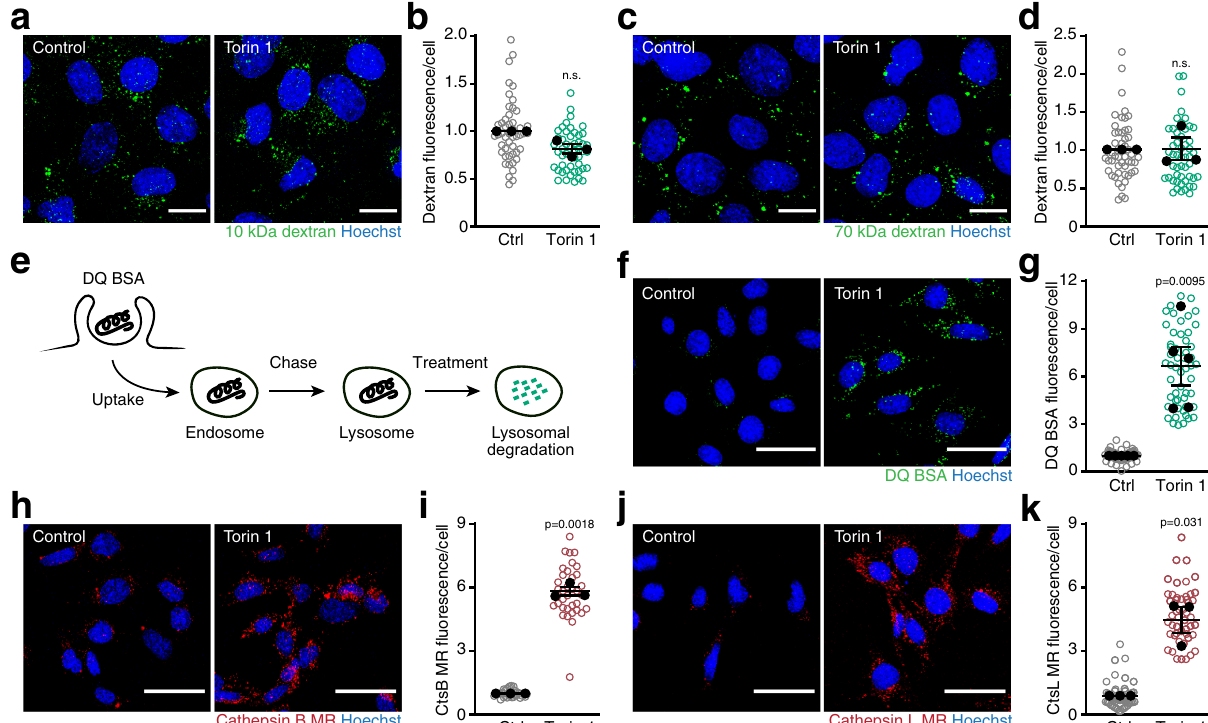
Fig. 1 | Degradation of extracellular proteins is suppressed by mTORC1 at the step of lysosomal catabolism. a – d Intracellular levels of fl uorescently labelled a , b 10kDa dextran, c , d 70kDa dextran in MEFs after 45min of uptake. Torin 1 [400nM] was added 15min before the experiment. Scale bars=20 µ m. e Schematic of lysosomal protein degradation assay based on preloading lyso- somes with DQ BSA and measuring dequenching of DQ BSA fl uorescence upon proteolysis. f , g Degradation of lysosomally preloaded DQ BSA in MEFs after